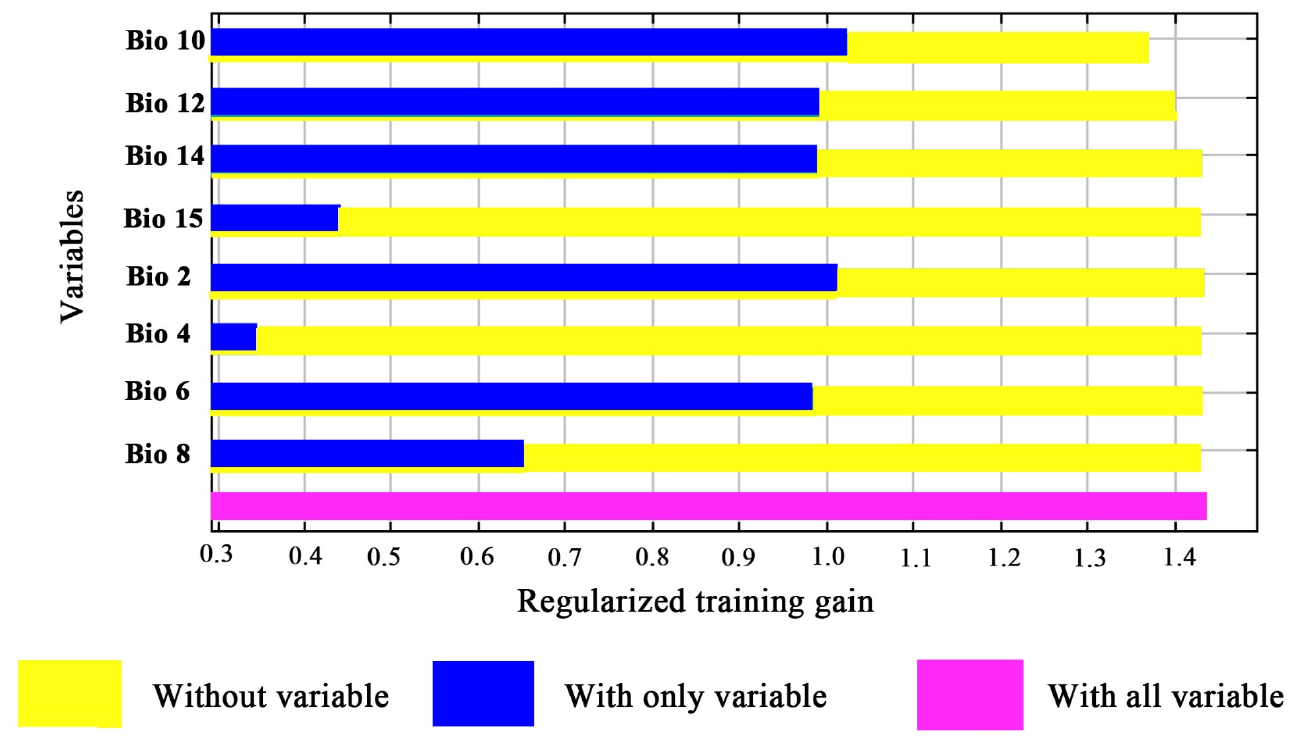
Figure 2. The Jackknife test results on the importance of bioclimate